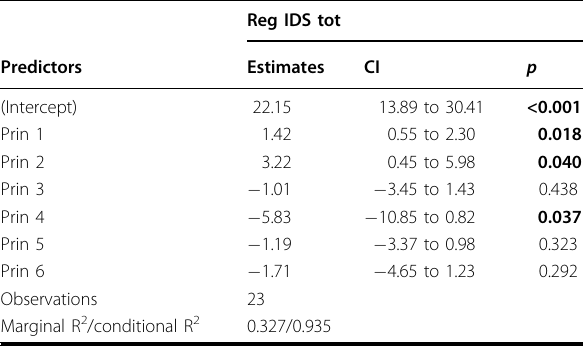
Table 3 Mixed effect model with principal components in sample of pregnant women.